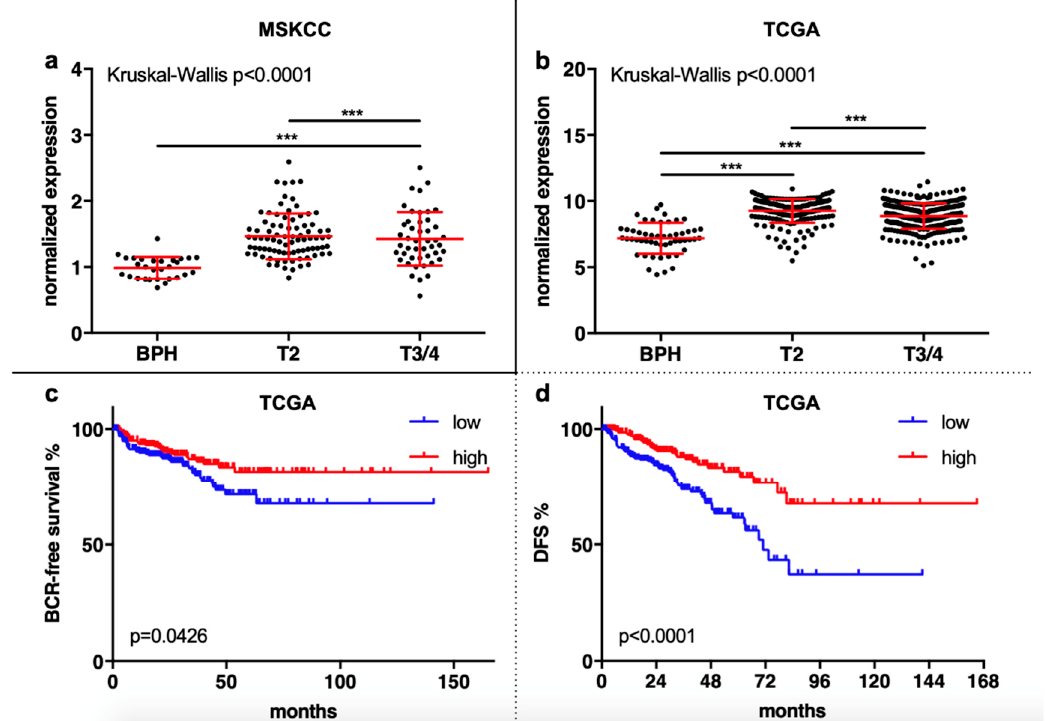
Figure 3. ( a ) and ( b ) Both in the Memorial Sloane Kettering Cancer Centre (MSKCC) and in The Cancer Genome Atlas (TCGA) cohort, the expression of SMPDL3B was higher in T2 and in T3/4 tumors compared to BPH. In the TCGA cohort, the expression was also significantly higher in T2 compared to T3/4 tumors. ( c ) and ( d ) A low expression of SMPDL3B was associated with a significantly shorter BCR-free survival and progression-free interval (PFI) in the PCa patients from the TCGA cohort. (*** p > 0.001)